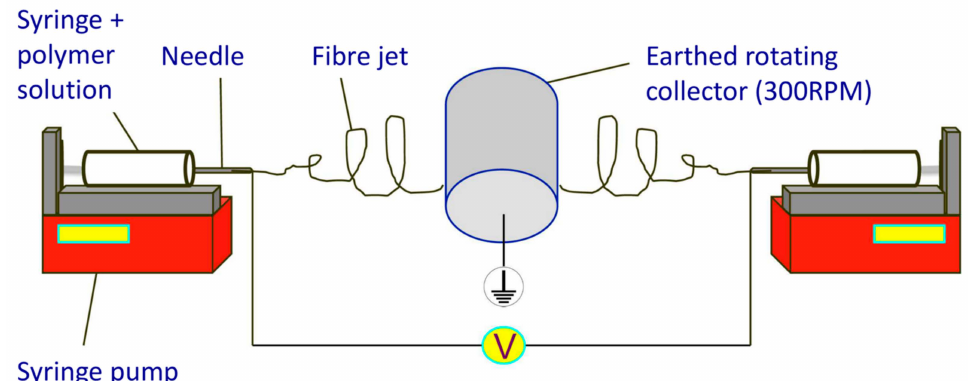
Figure 10. A graphical representation of the co-electrospinning setup used by Hillary and colleagues for the development of sca ff olds with improved biophysical properties and bioactivity [50]. Reprinted with permission from [50], PLoS ONE,